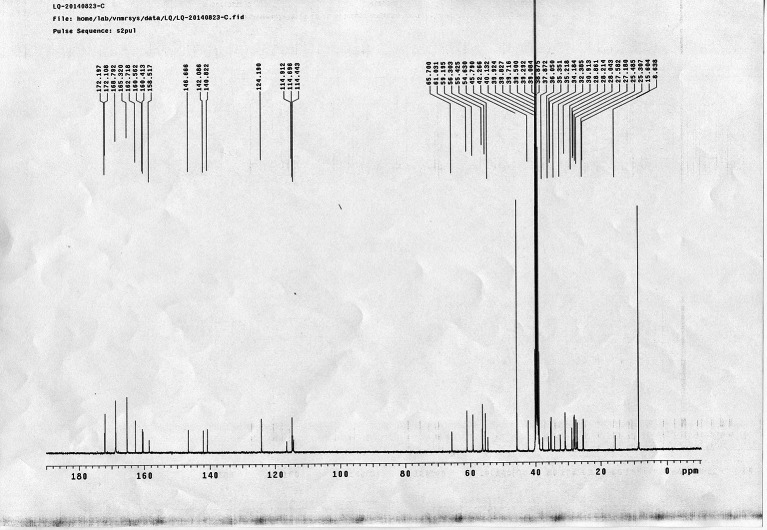
13C NMR spectra of bAL 2.